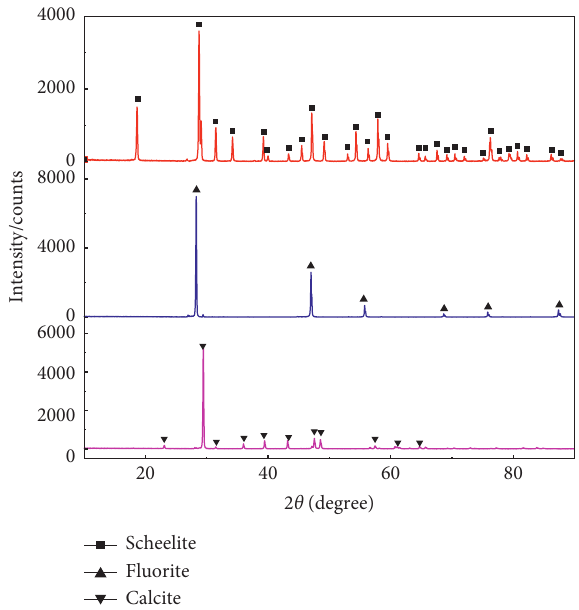
Figure 1: XRD patterns of powder scheelite, fluorite, and calcite for the AFM experiments and zeta potential